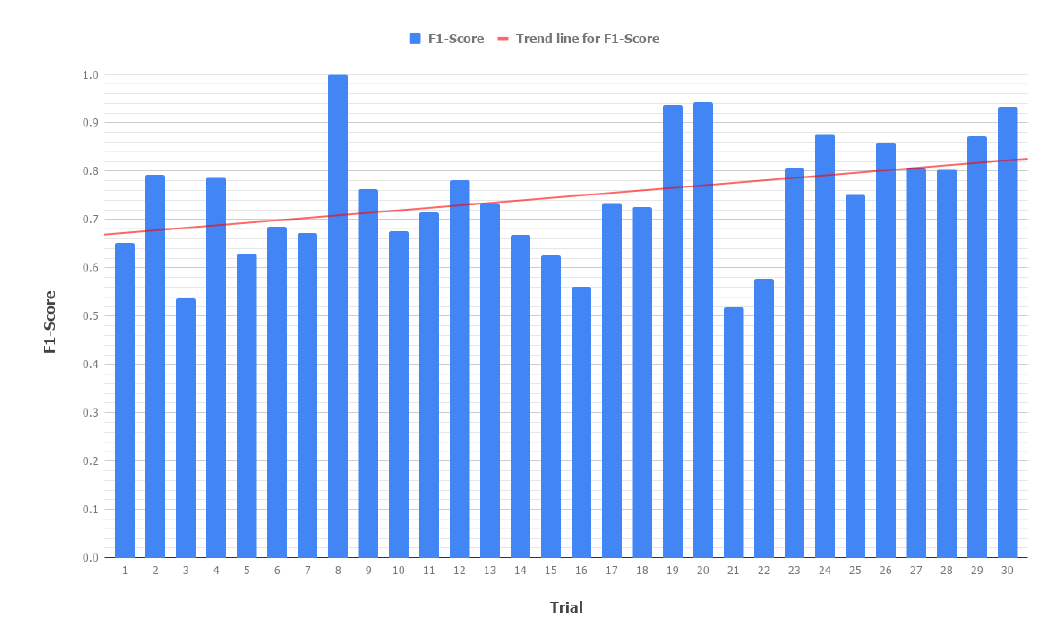
Figure 16. Average F1-score of the system for all the users along with the experiment’s trials. The positive slope of the trend line for the F1-score is an indicator of the adaptation of the users to the system. Please recall that none of the users followed the same sequential trial set since they were randomly